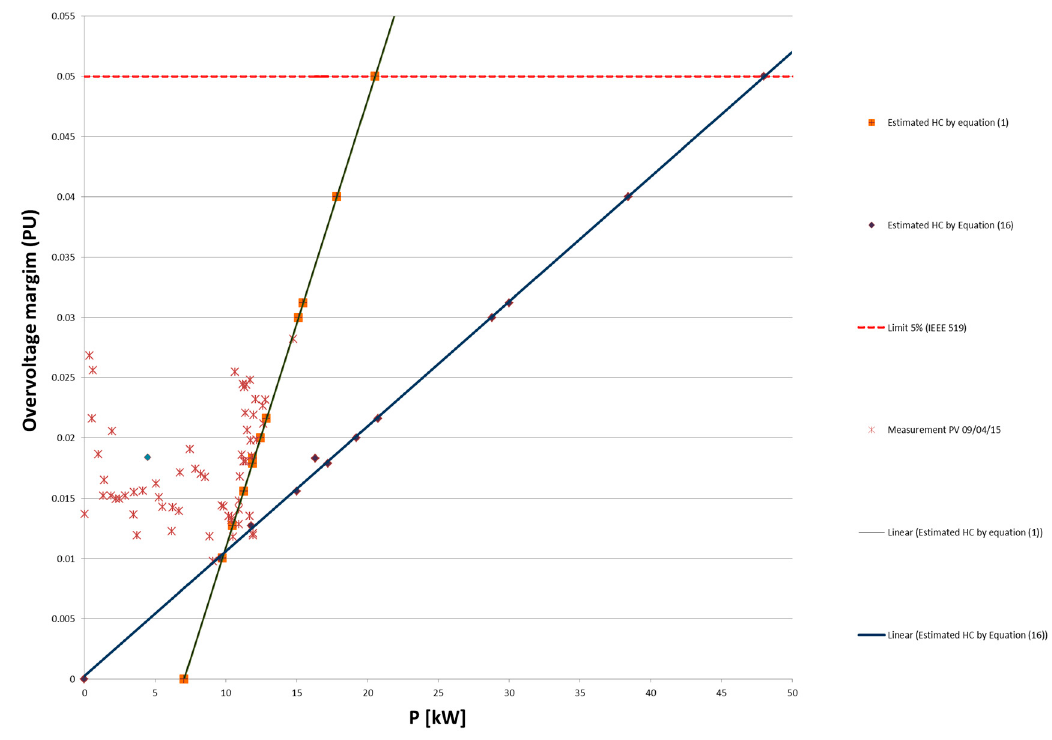
Figure 5. Hosting capacity validation against (1) and (14).